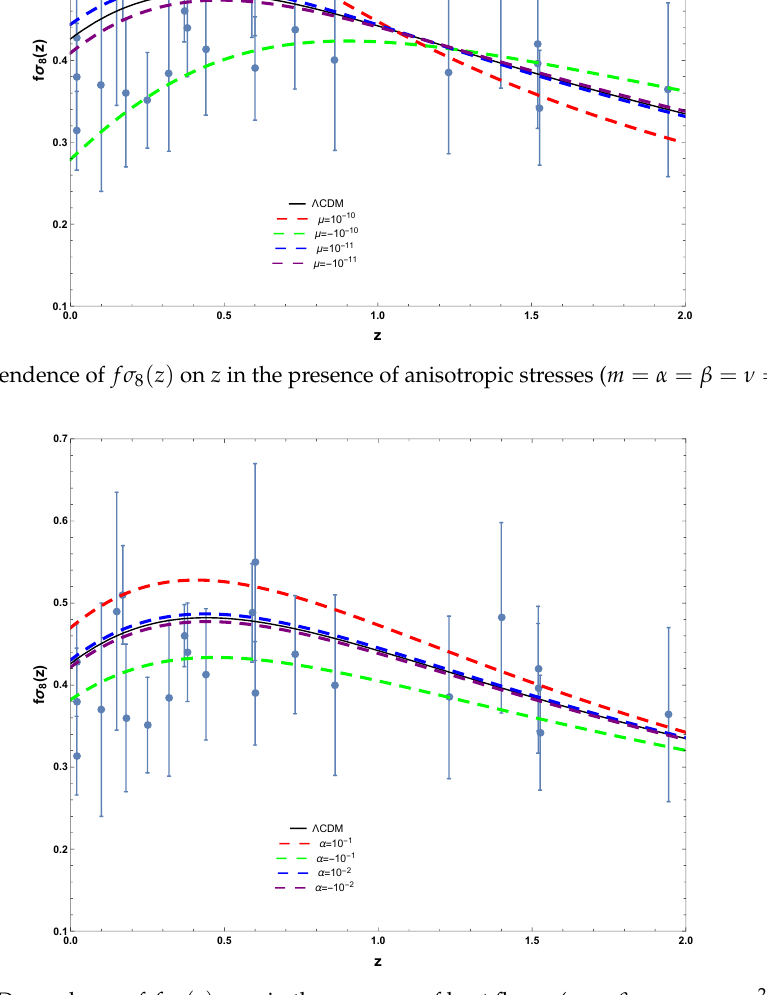
Figure 8. Dependence of f σ 8 ( z ) on z in the presence of heat fluxes ( m = β = µ = ν = c 2 ε =